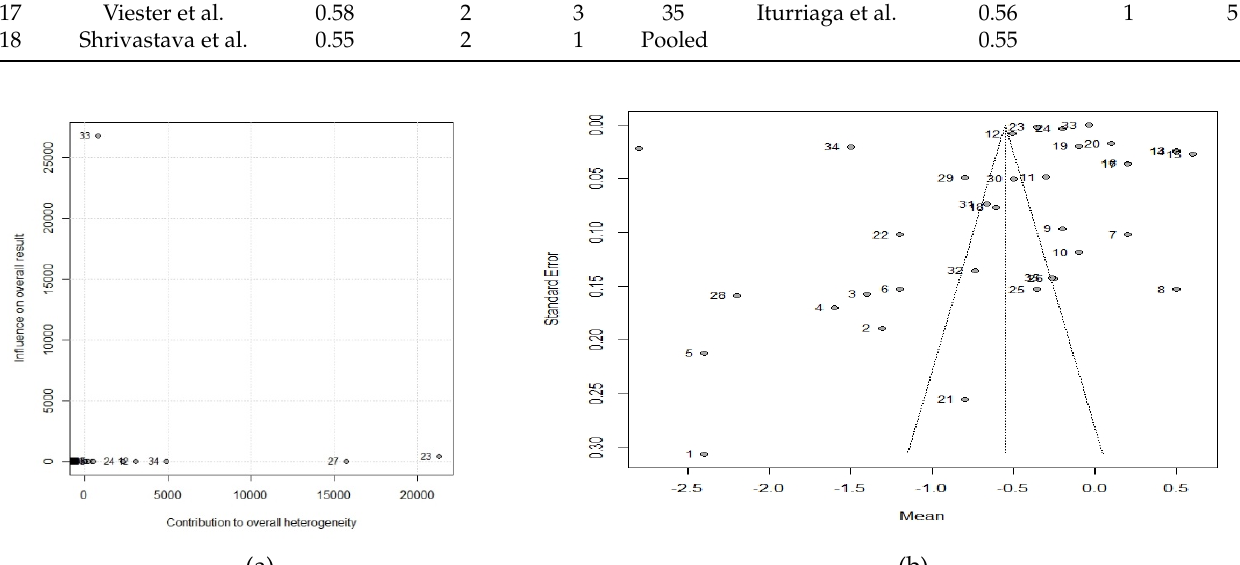
Figure 3. ( a ) Baujat plot for Body Mass Index ( b ) Funnel plot for Body Mass Index.